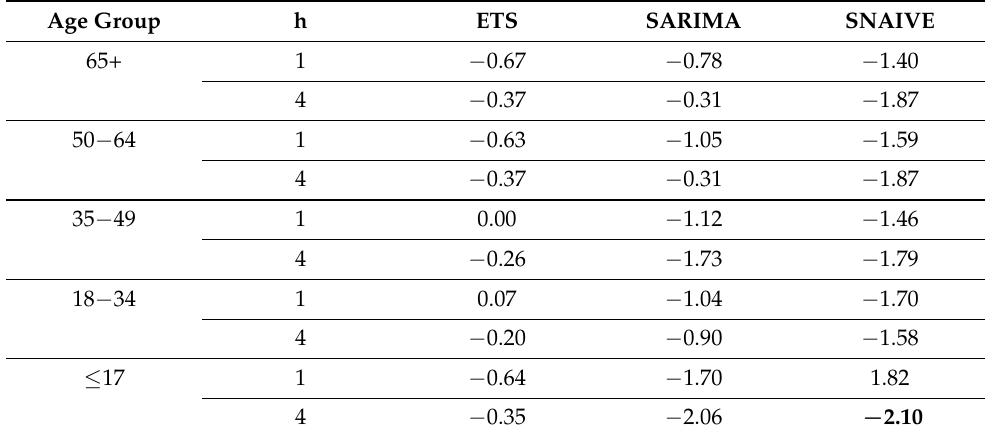
Table 6. Results of the modified Diebold–Mariano test comparing ITSA to ETS, SARIMA without intervention, and SNAIVE by age